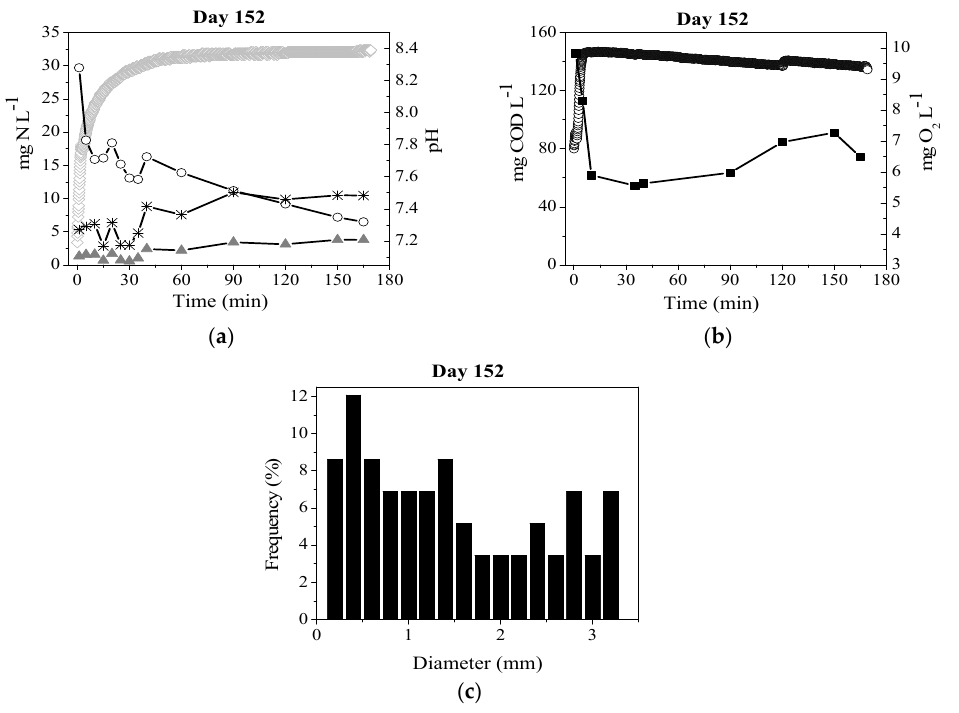
Figure 6. Cycle prolile on day 152 with aeration rate of 1.26 cm s − 1 . ( a ) Nitrogen compound concentrations and pH: N-NH 4 + ( ), N-NO 2 − (*), N-NO 3 − ( (cid:78) ), and pH ( ♦ ); ( b ) O 2 concentration ( (cid:35) and soluble COD ( (cid:4) ); ( c ) Granule size